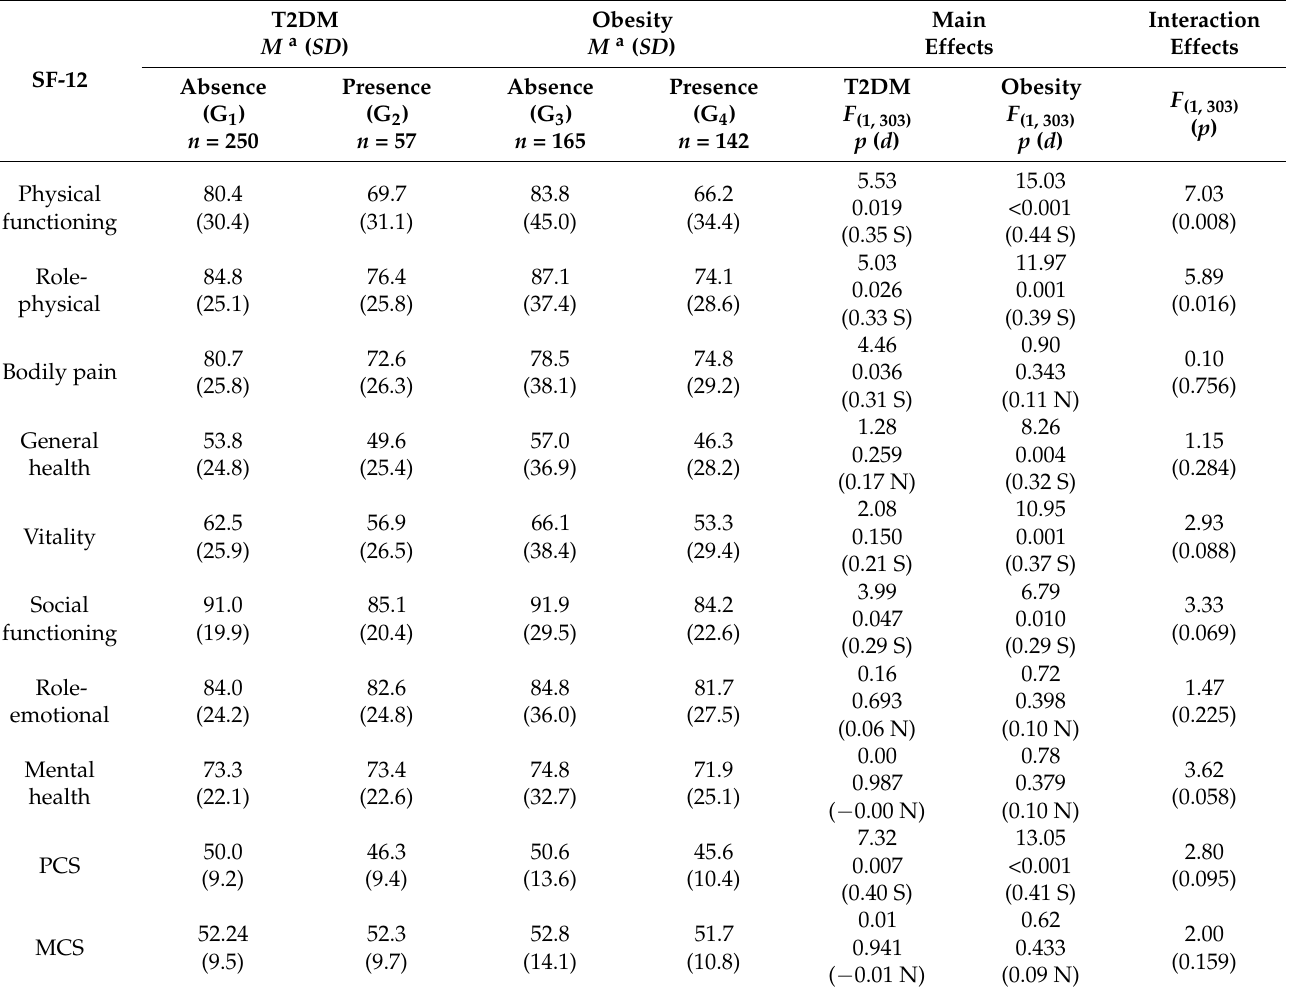
Table 2. Quality of Life (SF-12) of Patients with Nonalcoholic Fatty Liver Disease (NAFLD) by T2DM (Absence and Presence) and Obesity (Absence and Presence)